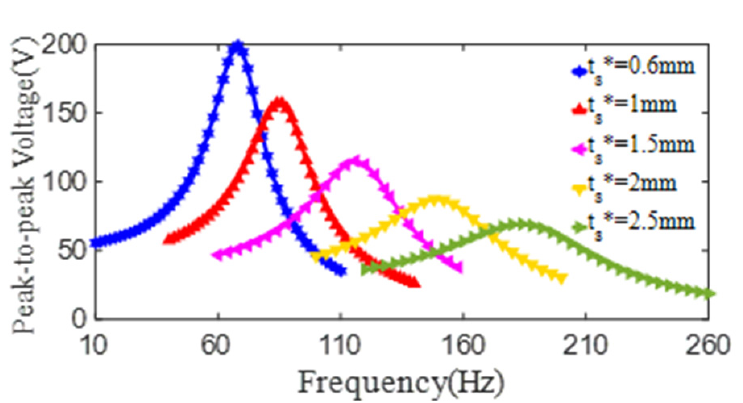
Figure 15. The relationship curves of the peak-to-peak voltage and the excitation frequency of PZT4 patch with different inner diameter ( D p * = 80 mm, t p * = 1 mm, t s * = 0.6 mm). The effect of the substrate thickness on the output voltage of the PCD is also further researched by the simulation method. In this computation process, the parameters are taken as d p* = 80 mm, D p* = 135 mm, t p* = 1 mm, d s* = 15 mm, and D s* = 218 mm; and the substrate thickness is changed from 0.6 mm to 2.5 mm. As displayed in Figure 16, when the substrate thickness of t s* is rising to 0.6 mm, 1.0 mm, 1.5 mm, 2.0 mm and 2.5 mm, the maximum peak-to-peak voltage from the PZT4 patch is 201 V at 65 Hz, 163 V at 82 Hz, 121 V at 115 Hz, 91 V at 150 Hz and 71 V at 180 Hz, respectively. From the data above, it can be founded that as the thickness of the substrate increases, the 1st resonant frequency of the PCD increases markedly, but the peak-to-peak voltage at this frequency decreases. Obviously, with the increase of its substrate thickness, the bending stiffness and the natural frequency of the PCD increases. Another key reason is that the excitation amplitude of the shaker decreases with the increase of its excitation frequency, which also leads to the decreases of the deformation and the generated voltage (at 1st resonance) of the PZT4 patch of the PCD with a bigger substrate thickness. On the basis of the experiment and simulation, the relationship curve of the peak-to- peak voltage of the PZT4 patch of the PCD and the substrate thickness of t s can be fitted using the equation as below: